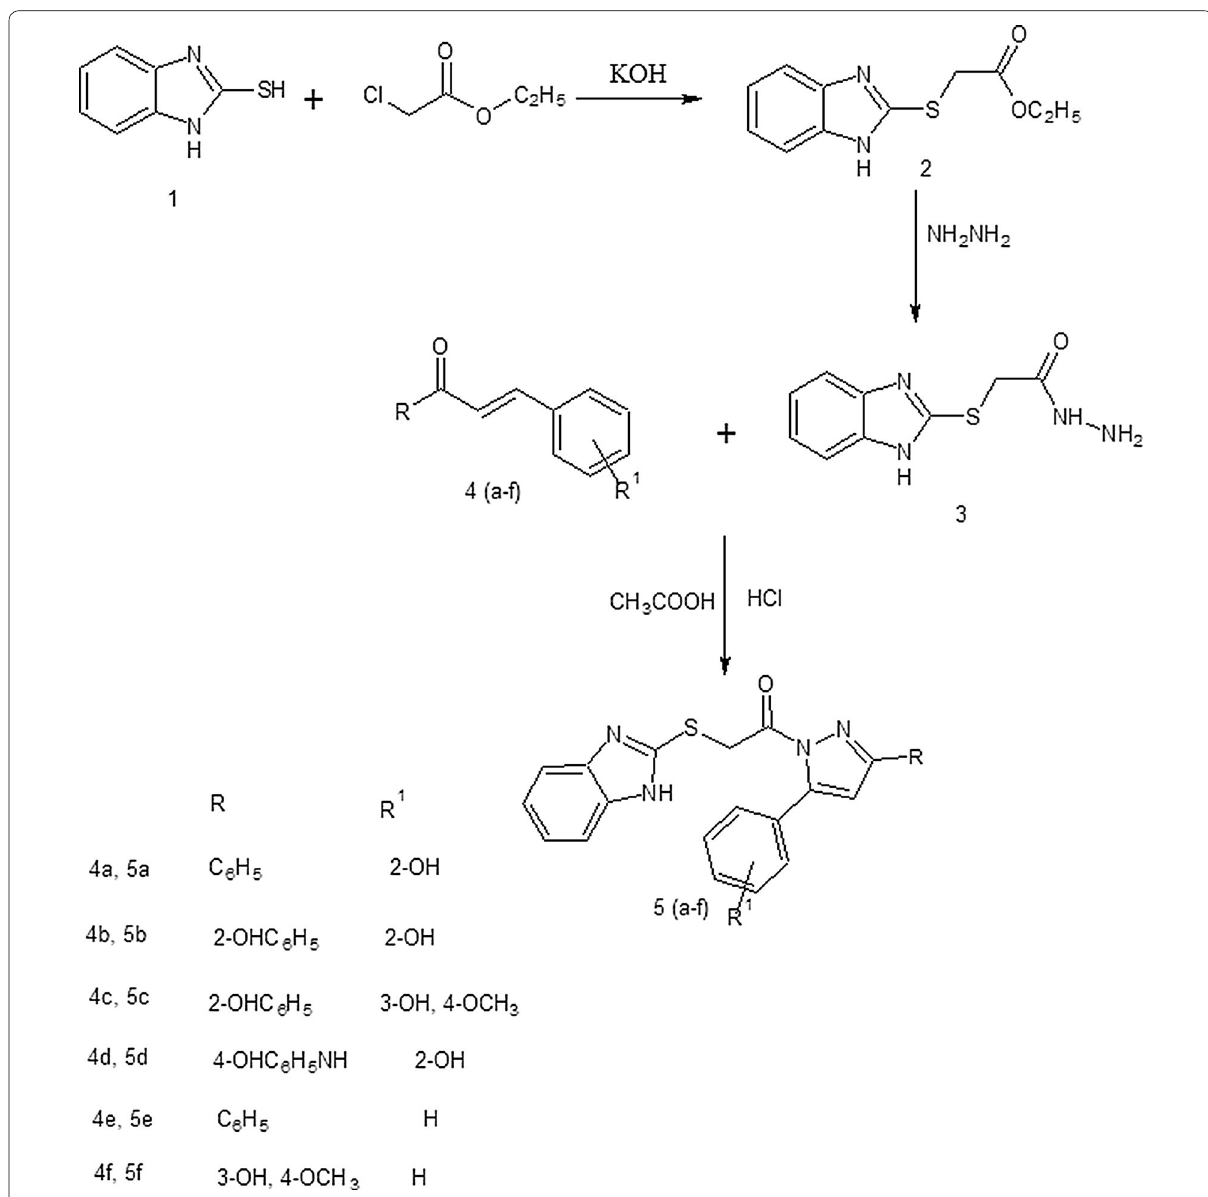
Fig. 1 Synthesis of Mercatobenzimidazole‑Pyrazole‑hybrid